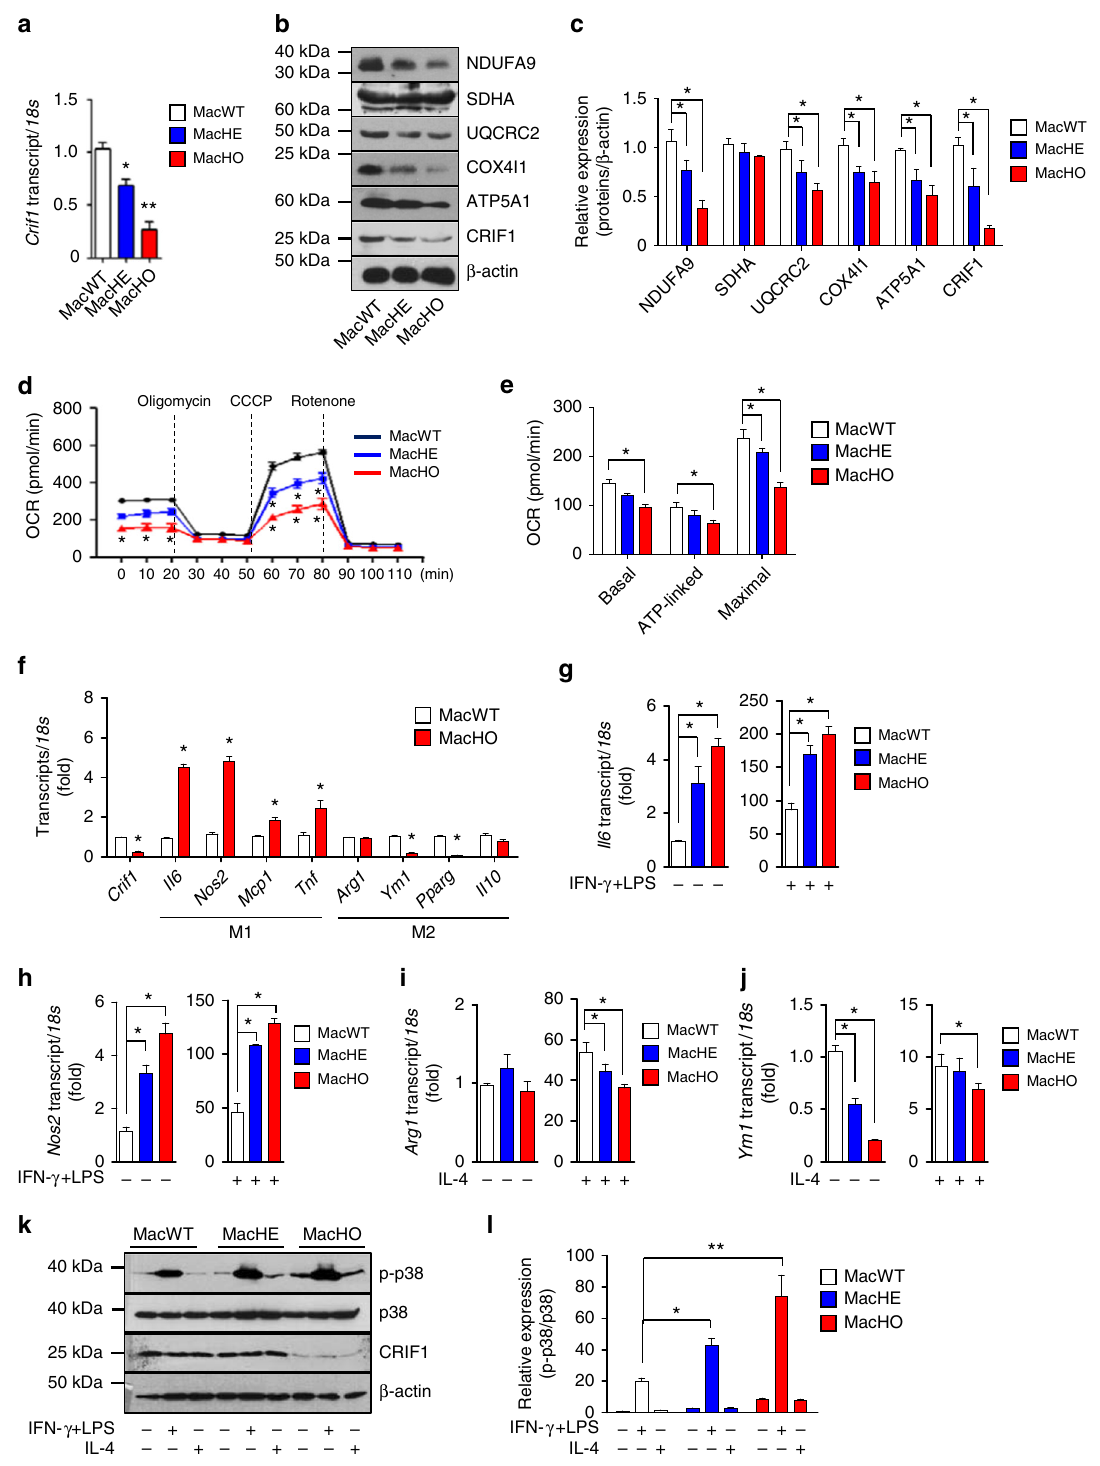
Fig. 1 Oxidative dysfunction by CRIF1 de fi ciency increases M1-like macrophages a Real-time PCR analysis of Crif1 in BMDMs from 8-week-old MacWT, MacHE, and MacHO mice. b , c Immunoblot analysis of OxPhos complex and CRIF1 expression in BMDMs from 8-week-old MacWT, MacHE, and MacHO mice. d , e Oxygen consumption rates (OCR) in BMDMs from 8-week-old MacWT, MacHE, and MacHO mice. CCCP: carbonyl cyanide m- chlorophenyl hydrazone. f Real-time PCR analysis of M1-related and M2-related genes in BMDMs from 8-week-old MacWT and MacHO mice. g , h Real- time PCR analysis of Il6 and Nos2 mRNA expression in the presence or absence of IFN- γ (10 ng/ml) and LPS (100 ng/ml). i , j Real-time PCR analysis of Arg1 and Ym1 mRNA expression in the presence or absence of IL-4 (20 ng/ml). k , l Immunoblot analysis of p38 phosphorylation after exposure to IFN- γ (10 ng/ml) and LPS (100 ng/ml) for 30 min. Data are expressed as means± SEM and are representative of three independent experiments ( n = 5 mice per group). * p < 0.05 or ** p < 0.01 (two-tailed Student ’ s t